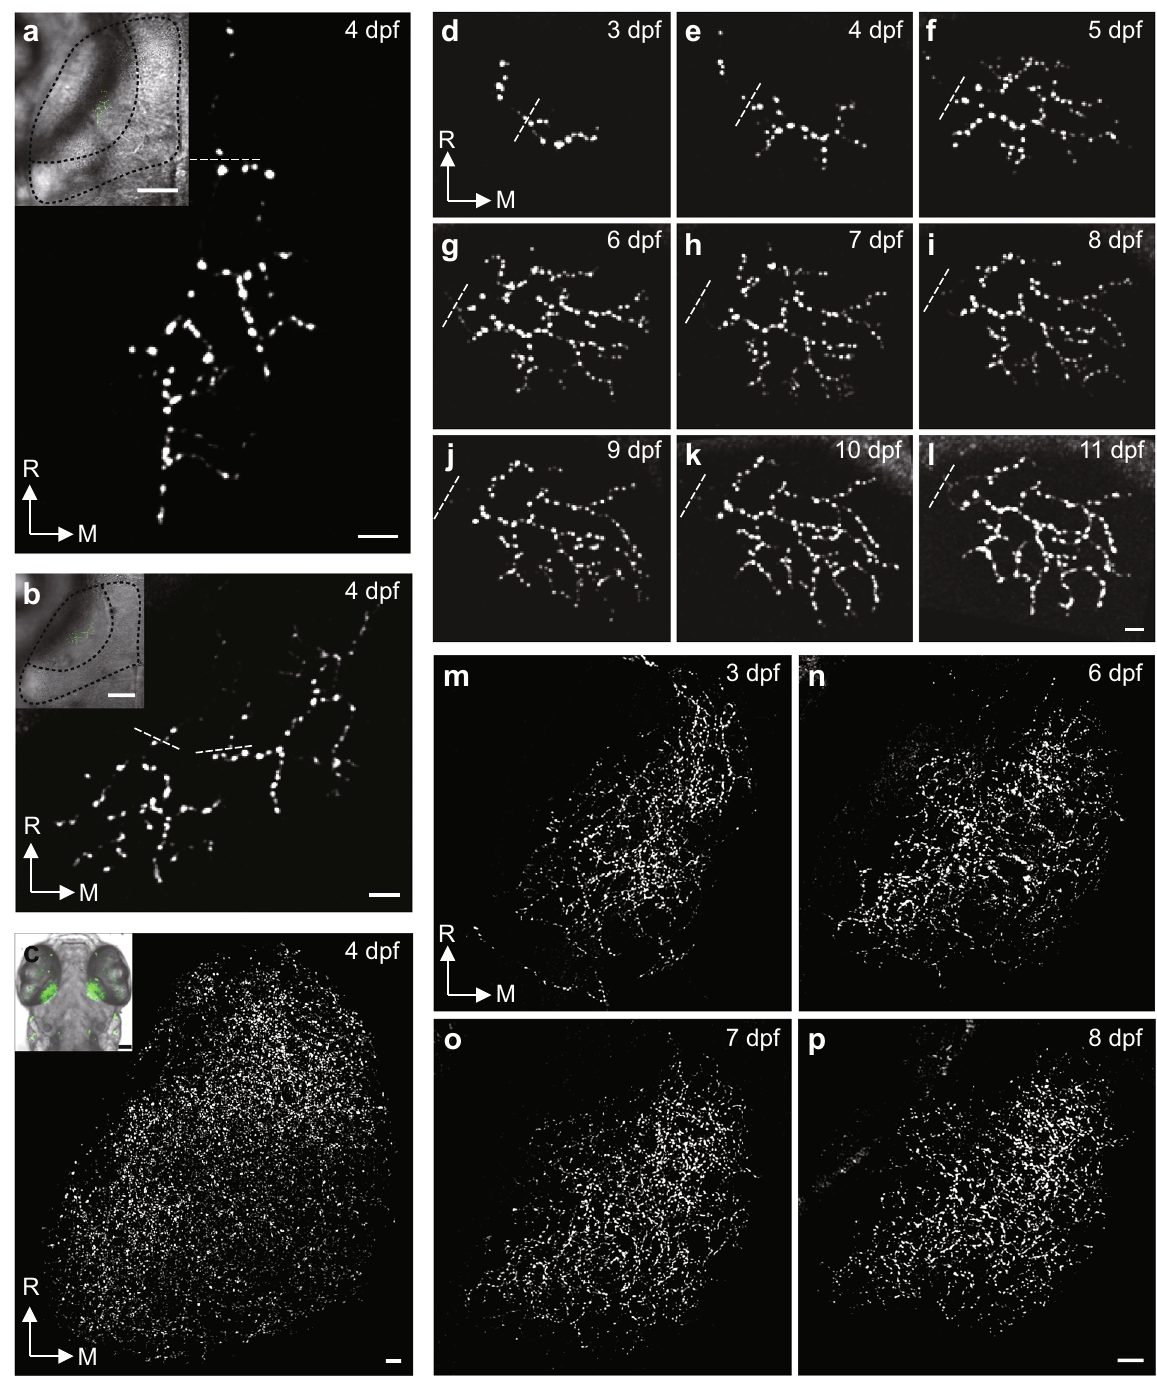
Figure 2. Long-term stable in vivo imaging of retinotectal pre-synaptic terminals in PGUSG larvae with single or multiple RGCs labelled. ( a – c ) Examples of single ( a ), two ( b ) and multiple ( c ) Sypb-EGFP labelled RGC axonal arbors within one tectal hemisphere from different PGUSG fish at 4 dpf. Insets, topographic position of RGC axonal arbors in the tectal neuropil. In each inset, an optical section of bright-field image and a stack of green fluorescent images are superimposed. Dashed black curve, the profiles of half tectum and half neuropil. ( d–p ) Time series showing maximum-intensity-projection view of the same single ( d–l ) and multiple ( m–p ) Sypb-EGFP labelled RGC axonal arbors at 3–11 dpf and at 3, 6, 7 and 8 dpf, respectively. Autofluorescence of the skin is visible in the right upper corner in panel ( j ), ( k ) and ( l ). Dashed white line, position above the first branch point of each axonal arbor. R, rostral; M, medial. Scale bar: 5 μ m in each panel; 50 μ m in panel